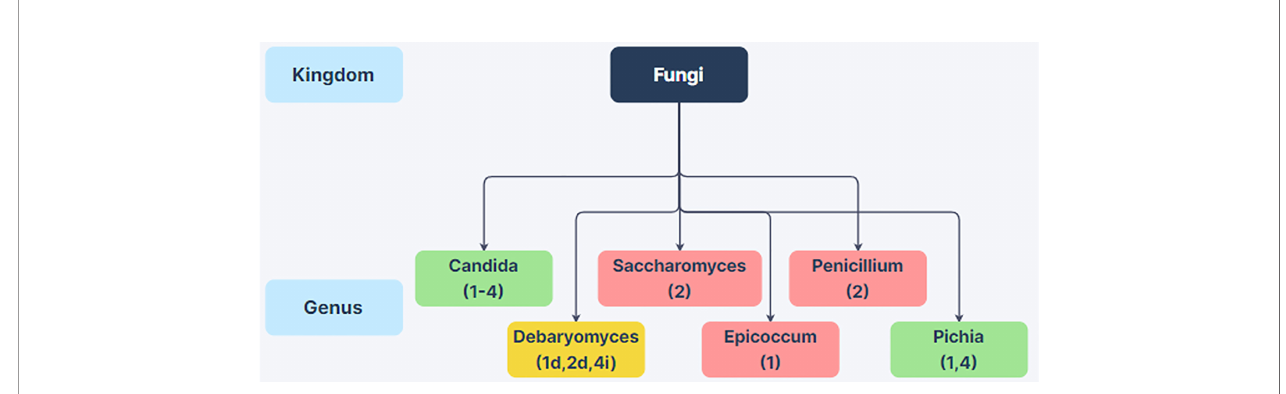
FIGURE 2 | Changes in Fungal Abundance in the Alcoholic GI Tract. Genus-level differences in fungal abundance between the gut mycobiome in patients with alcohol-use disorder or varying stages of alcoholic liver disease relative to non-alcoholic humans from 4 human studies. Green boxes indicate increased abundance in alcoholics and red boxes indicate decreased abundance in alcoholics. Yellow boxes indicate con fl icting information between studies. Citations are noted below the fungal name. Taxa with con fl icting information have decreased or increased abundance in the alcoholic GI tract noted with a d or i next to the citation,